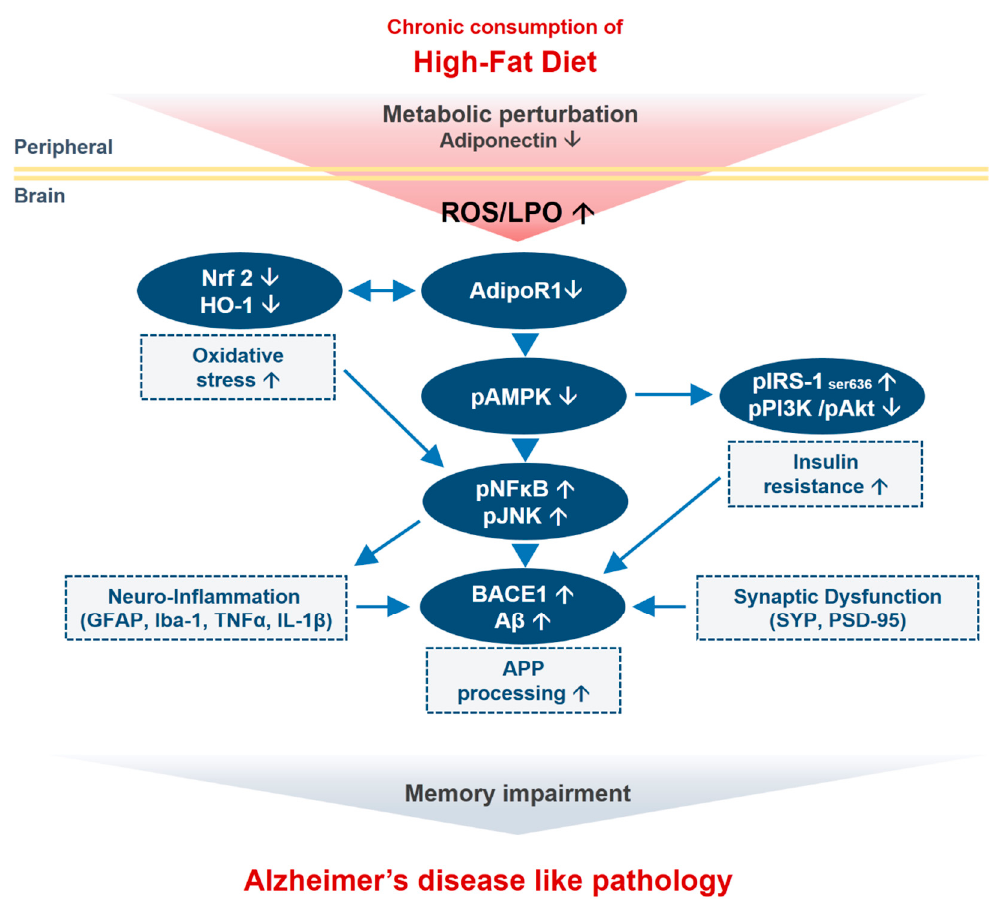
Figure 8. Schematic outline representing neuronal adiponectin signaling pathway in the brain upon consumption of HFD. Chronic consumption of HFD along with several inciting factors (metabolic perturbation and adiponectin deficiency) in periphery leads to oxidative stress and AdipoR1 suppression along with its downstream signaling molecules (energy depletion; p-AMPK) in the brain. This leads to insulin resistance and increased APP processing (increased in BACE-1 and A β level). Abnormal accumulation of A β is accompanied by neuroinflammation and synaptic dysfunction that together leads to memory impairment and Alzheimer-like pathology in the mouse brain.